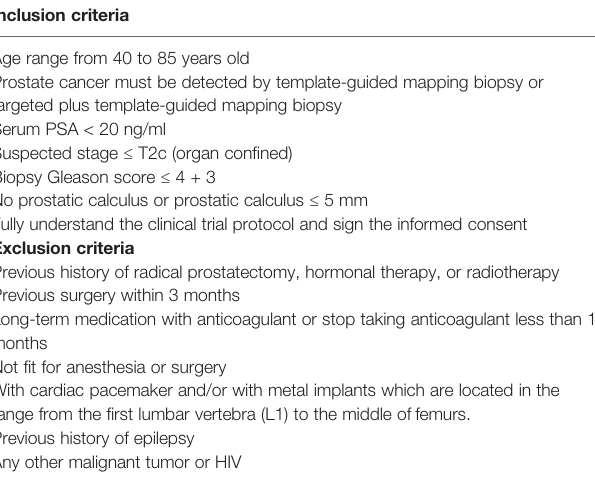
TABLE 1 | Patients inclusion and exclusion criteria. Inclusion